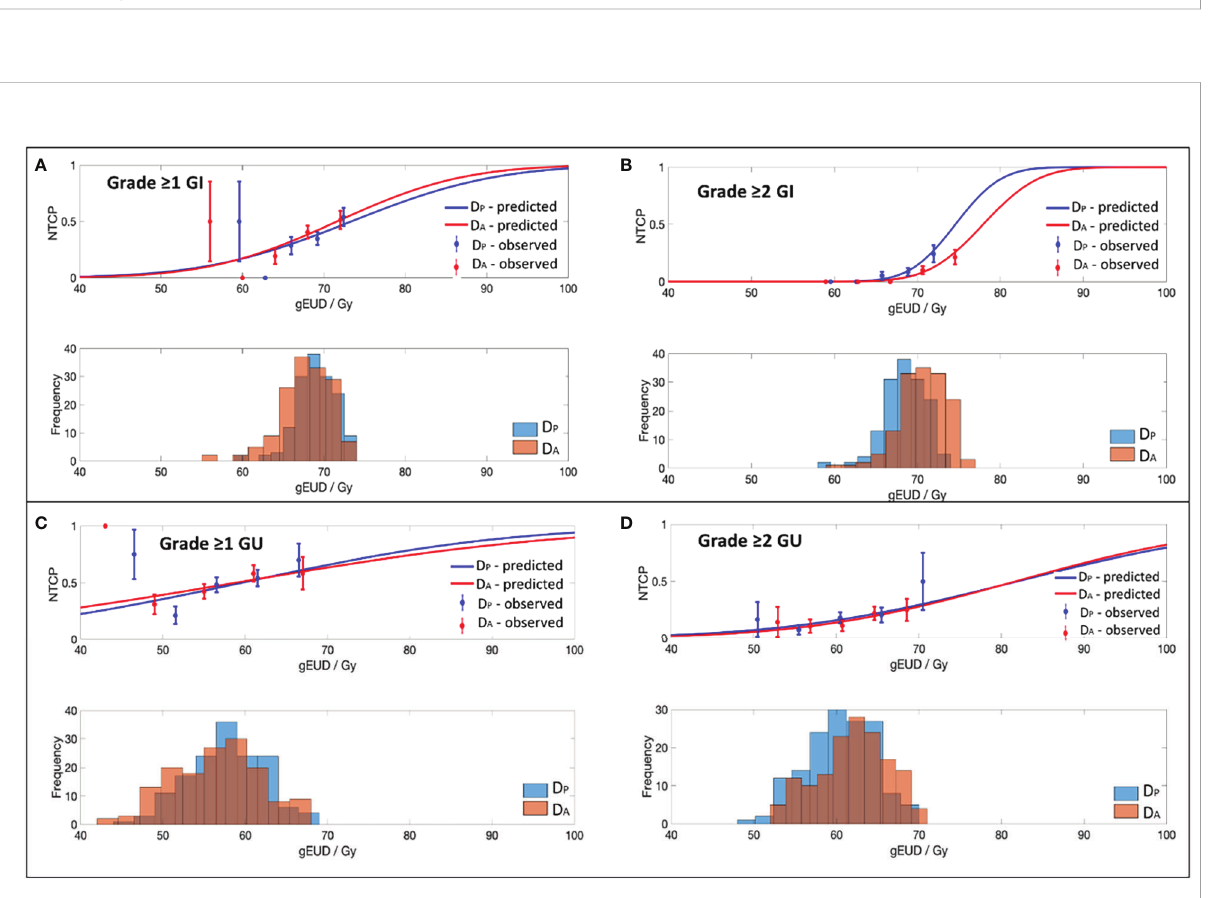
FIGURE 1 Dose-volume response curves and histograms obtained with the best- fi t parameters and 95% CI for the EUD-based NTCP model for (A) Grade ≥ 1 GI, (B) Grade ≥ 2 GI, (C) Grade ≥ 1 GU and (D) Grade ≥ 2 GU toxicity.